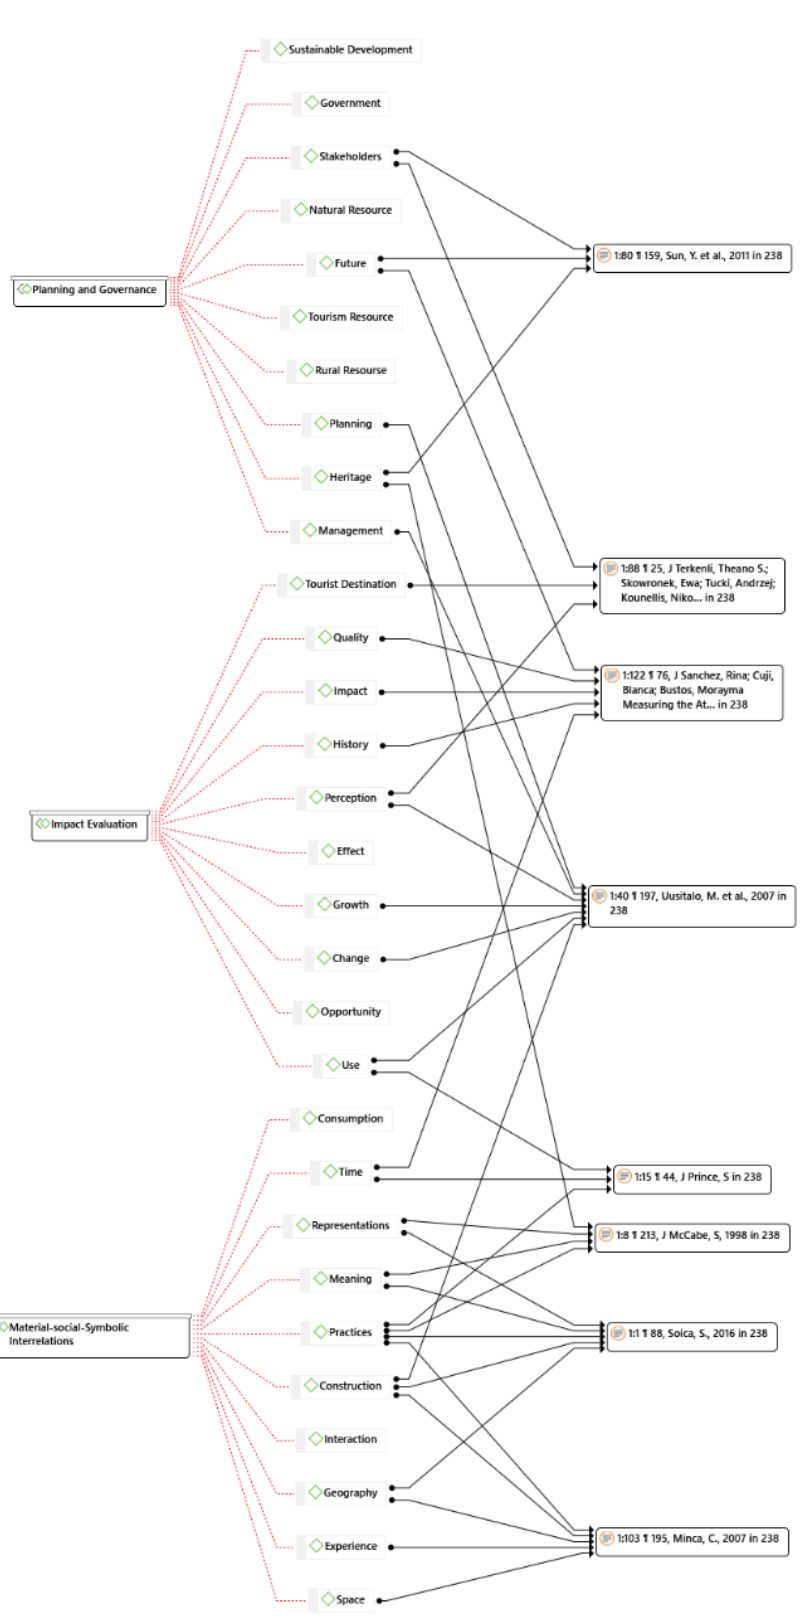
Figure 8. The hierarchical scheme of group-codes, codes, and quotations with exemplifying publications by ATLAS.ti. To avoid a visual representation with too much overlapping content, only a few linked quotations have been selected to be displayed.